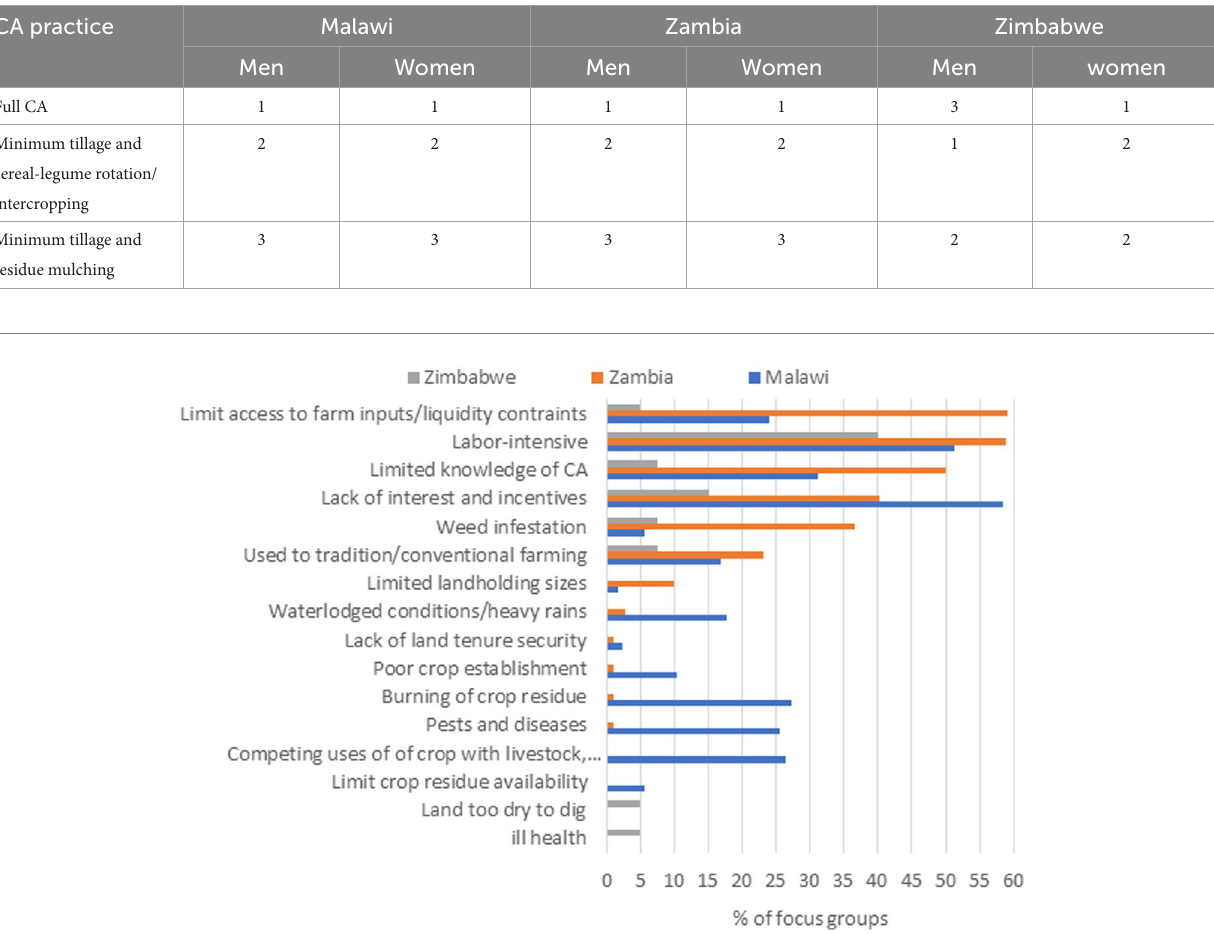
TABLE 5 Pairwise ranking of the preferences of CA practices by country and gender of the focus group.